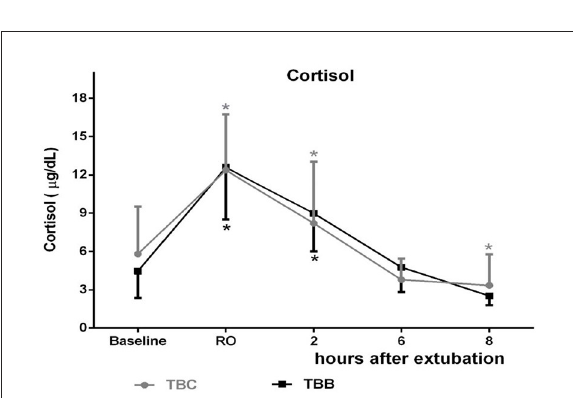
Animals were fasted for at least 8h for food and 4h for water.